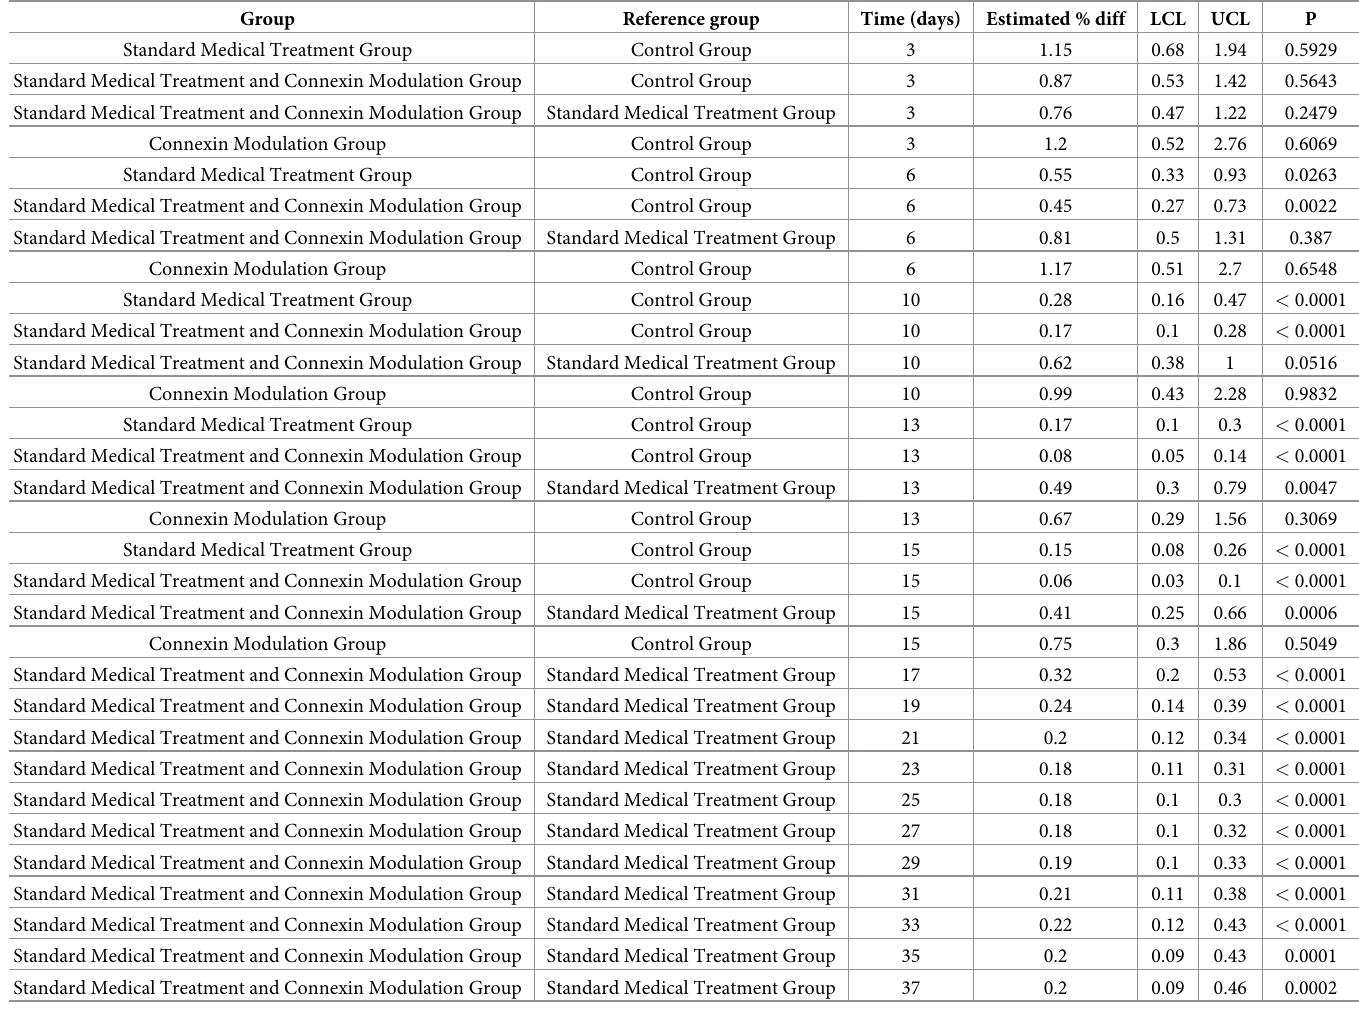
Table 2. Comparison of estimated mean tumor volumes between treatment